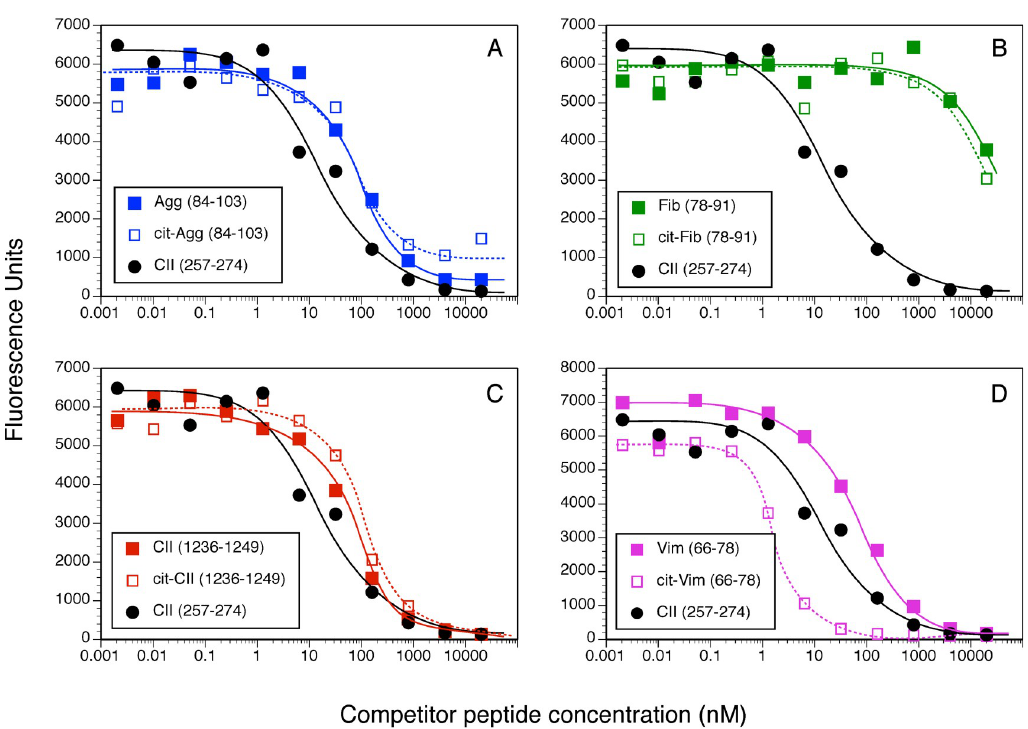
Fig 1. Measurement of peptide binding to DRB1 � 01:01. 10 nM of soluble DR1 was incubated for 18 h at 37˚ C with 0.5 nM of biotinylated CII(257–274) peptide and various concentrations of WT and Cit-peptides as competitors. Bound peptides were separated from free peptides by immobilizing the DR molecules with an antibody on microtiter plates. Bound biotinylated peptide was detected by incubation with streptavidin-europium. Time resolved fluorescence was quantitated and data are expressed as relative fluorescence units measured. Each binding assay was performed in duplicate, and data are representative of 3 experiments.